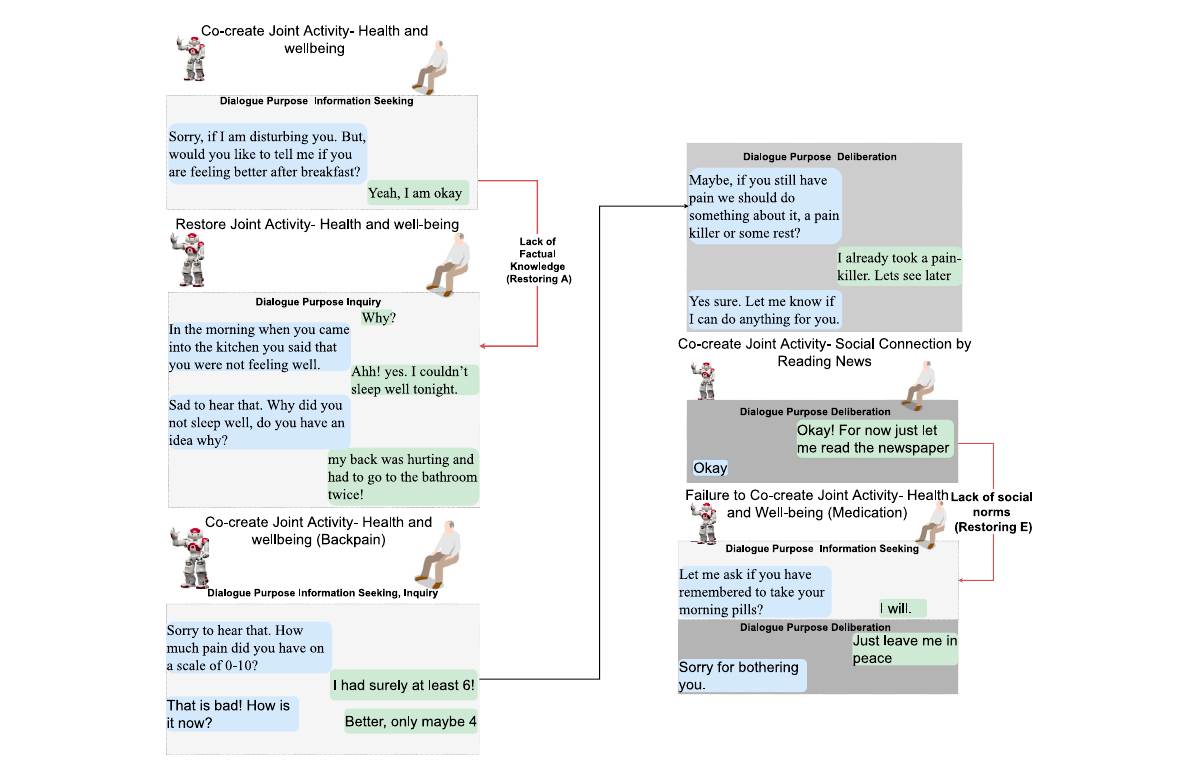
FIGURE 5 Scenario3a — RfollowsuponH ’ swell-beingifHindicatedearlierafterwakingupthathe/shewasnotfeelingwell.Thedialogueunfoldsintoco- constructing collective activities about medication and well-being, while breakdowns due to con fl icting motives, lack of factual knowledge, and social norms are being managed ( restoring D , A , E , refer to Figure 2). Text highlighted in blue represents R ’ s utterances, and text in green is H ’ s